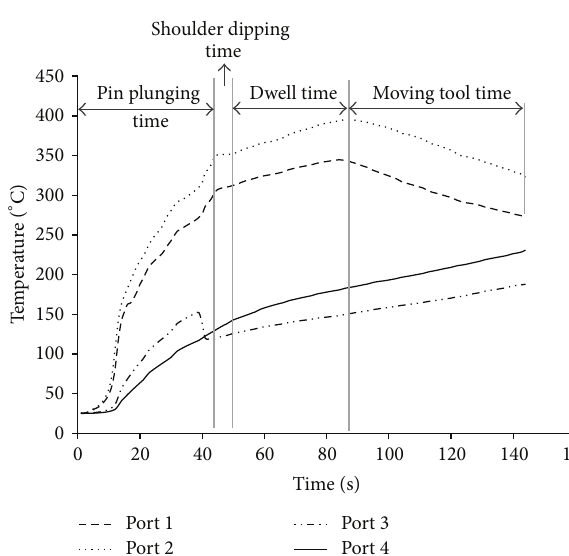
Figure 5: Temperature values and distribution at 𝜔 = 1000 rpm and DT = 5 s–40s. Ports 5, 6, 7, and 8 were neglected (no significant change).